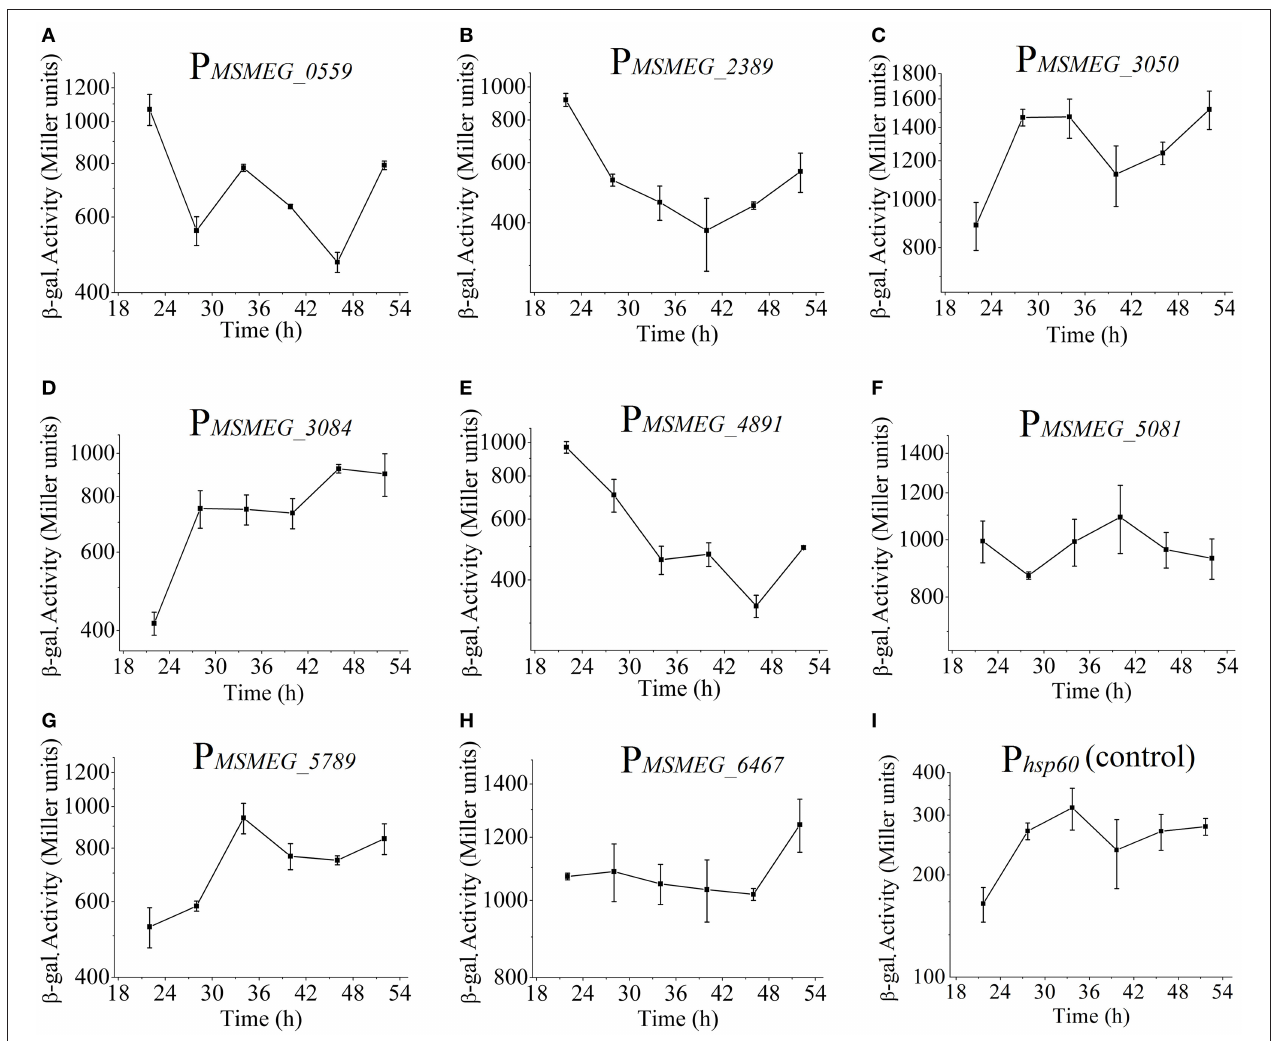
FIGURE 10 | Screening and identification of highly active promoter. P MSMEG_0559 represents mc 2 155/pMV261-P MSMEG_0559 -lacZ strain, and the same as below. β -galactosidase activities for the nine strains ( Phsp60 as a control) were shown in (A–I) . Data represent the averages of biological triplicates. Error bars indicate standard